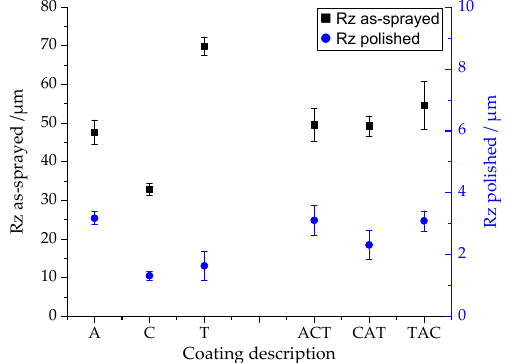
Figure 3. Roughness values of as-sprayed and polished coated samples.